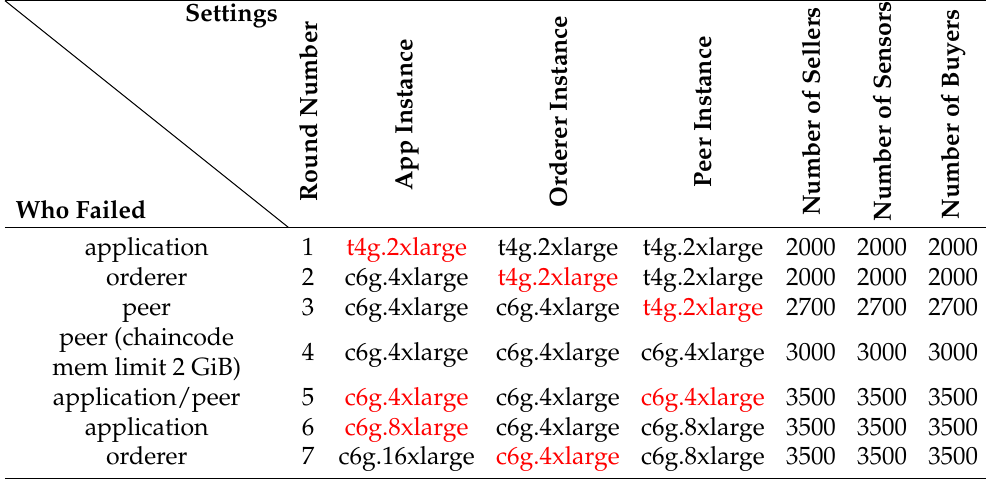
Table 3. Configurations that lead to failure in Phase 2. The instances which indicated failure are highlighted in